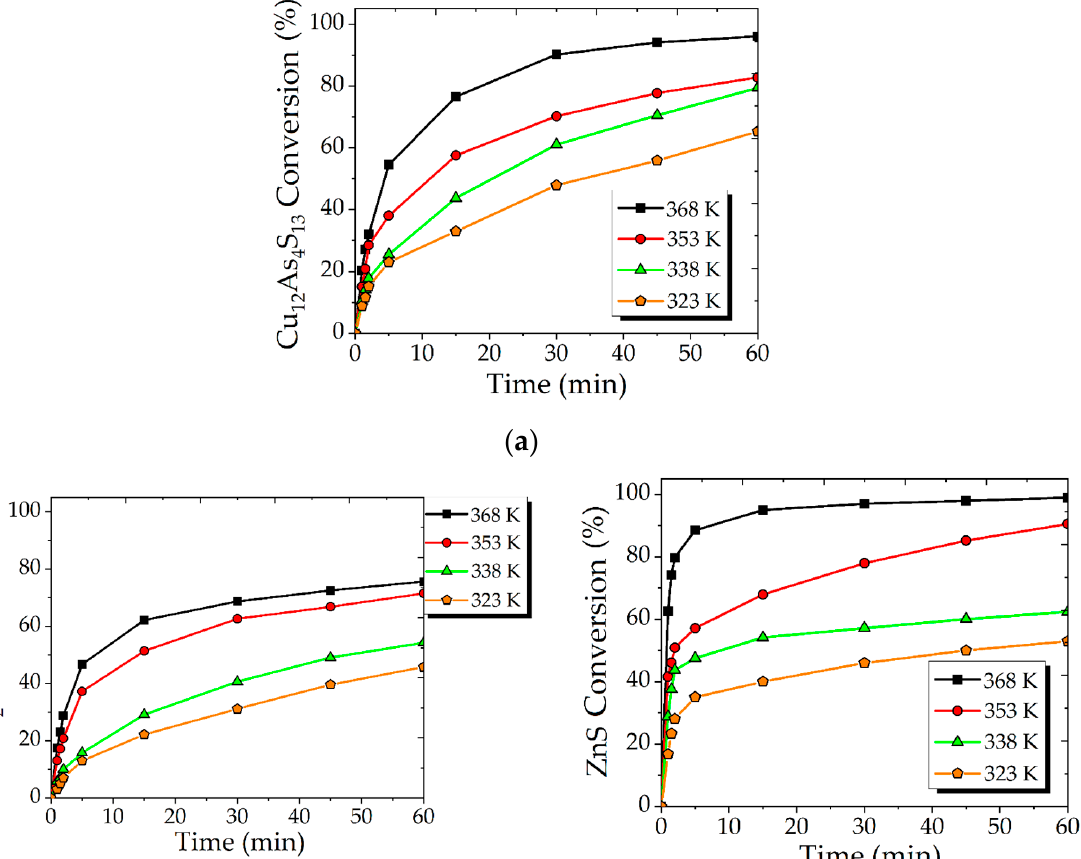
Figure 2. Effect of temperature on the conversion of Cu 12 As 4 S 13 ( a ), CuFeS 2 ( b ), ZnS ( c ). (300 rpm; 6 mol/L HNO 3 ; 0.018 mol/L Fe (III); FeS 2 /synt. conc = 1/1). According to the conversion profiles, the progress of the reaction was observed to slow down with time. Additionally, the presence of a clear inflection line in curves allowed us to suggest an internal diffusion mechanism of the interactions. The possible internal